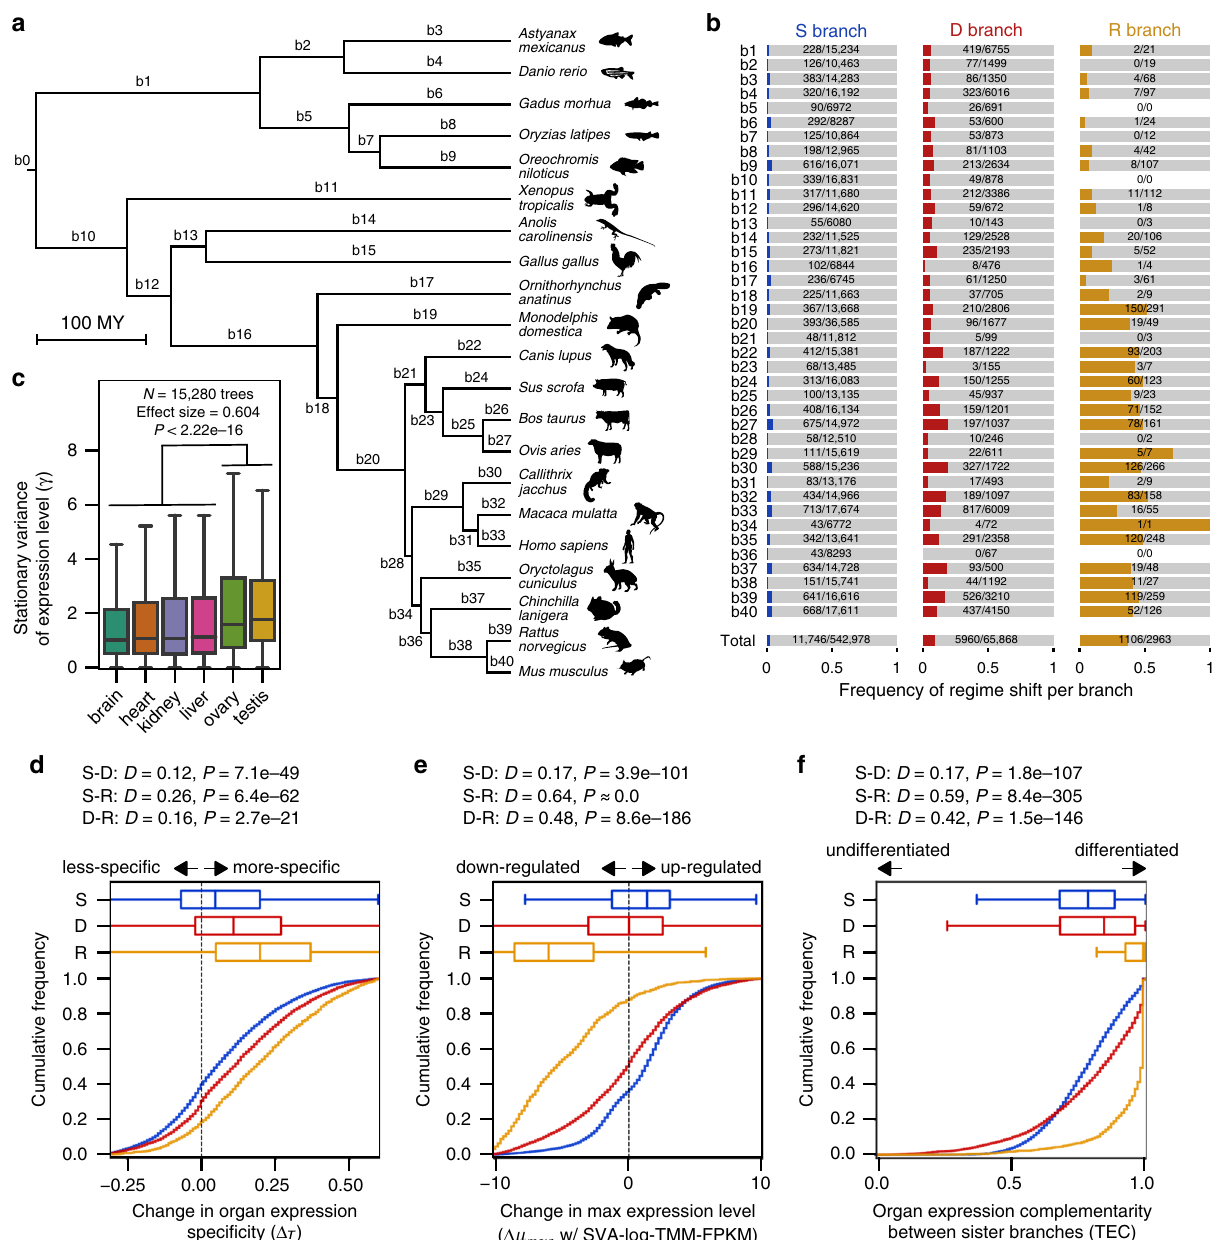
Fig. 3 Characteristics of expression shifts in 15,280 gene trees. a The species tree showing analyzed genomes and their divergence time. A part of animal silhouettes were obtained from PhyloPic (http://phylopic.org). The silhouettes of Astyanax mexicanus and Oreochromis niloticus are licensed under CC BY- NC-SA 3.0 (https://creativecommons.org/licenses/by-nc-sa/3.0/) by Milton Tan (reproduced with permission), and those of Anolis carolinensis (by Sarah Werning), Ornithorhynchus anatinus (by Sarah Werning), and Rattus norvegicus (by Rebecca Groom; with modi fi cation) are licensed under CC BY 3.0 (https://creativecommons.org/licenses/by/3.0/). b Mapping of 18,812 expression shifts in the species tree. The number and proportion of expression regime shifts in S, D, and R branches are shown. Corresponding branches in the species tree are indicated in a . c Organ-speci fi c stationary variances ( γ ) of expression level evolution in vertebrates. The distribution of γ between reproductive and nonreproductive organs were compared by a two-sided Brunner – Munzel test 95 . d – f Cumulative frequency of change in organ expression speci fi city ( d ), change in maximum expression level ( e ), and expression complementarity between sister lineages ( f ) among detected expression shifts. Number of analyzed regime shifts are shown in b . The D statistics and P values of pairwise branch category comparisons were calculated with two-sided Kolmogorov – Smirnov tests. Boxplot elements are de fi ned as follows: center line, median; box limits, upper and lower quartiles; whiskers, 1.5 × interquartile